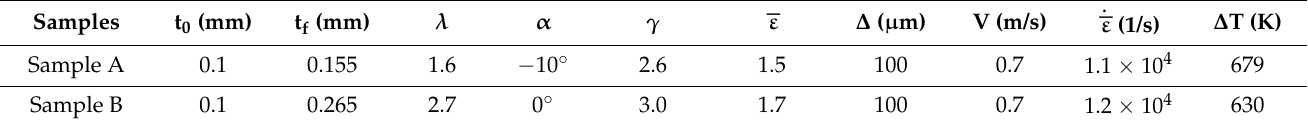
Table 2. LSM input and output parameters for samples